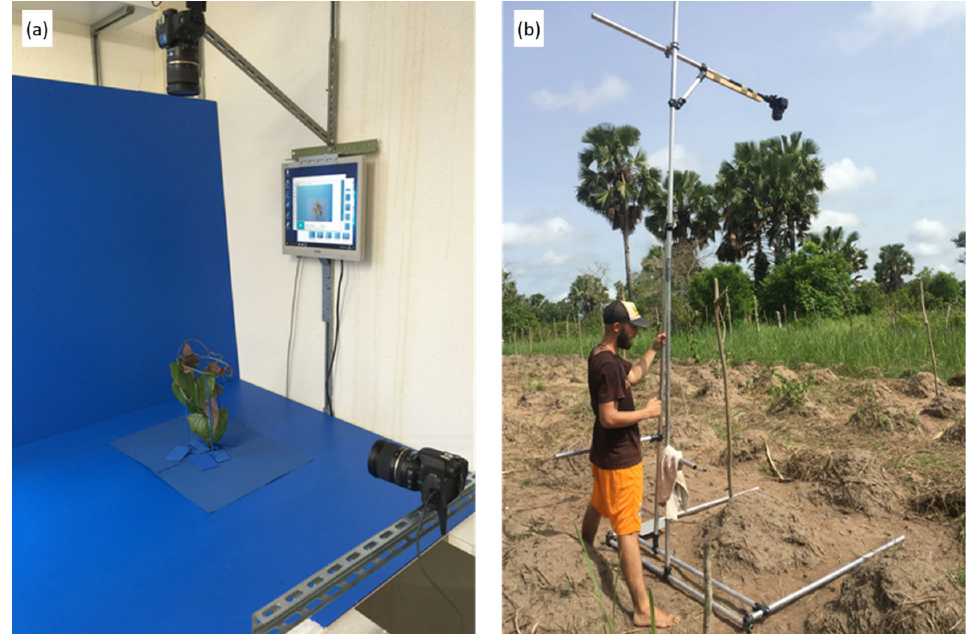
Figure 1. ( a ) Indoor imaging station with two cameras used for yam imaging at ETH Zurich plant research station in Eschikon and ( b ) the field-imaging platform with one camera in nadir view as moved over the field by the imaging operator in Côte d’Ivoire.